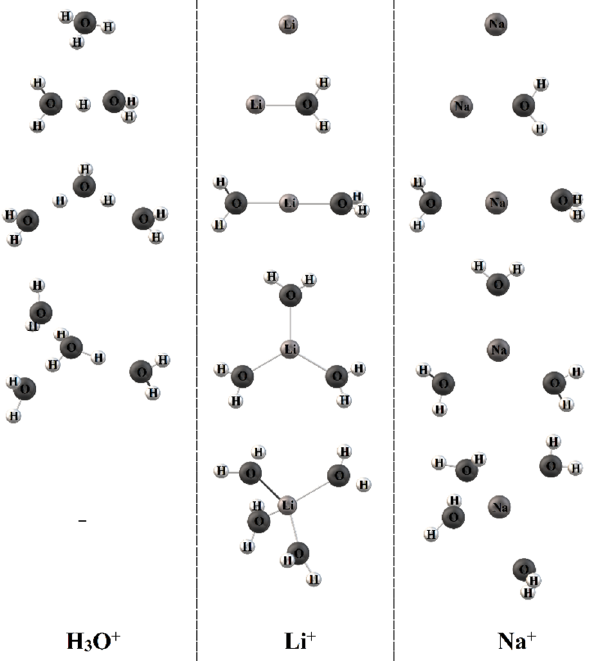
Figure 12. Optimized geometries of the X + (H 2 O) n clusters, where X + is H + , Li + , and Na + cations. Reprinted with permission from Ref. [74]. Copyright © 2022 American Chemical Society.